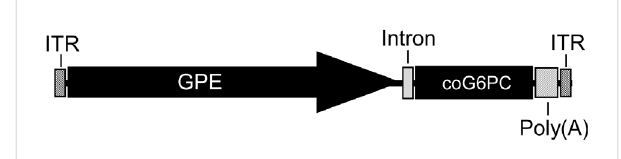
FIGURE 8 The clinical rAAV8-GPE-coG6PC construct. The AAV2/8 serotype contains the construct packaged in the AAV8 capsid. The construct consists of the AAV2 ITR fl anking each end, with the human G6PC promoter/enhancer (GPE, − 2,864 to − 1 nucleotide region of the human G6PC gene), a synthetic intron (137 bp), the codon- optimized (co) human G6PC coding sequence (1074 bp), and a SV40Poly(A)tail(~240 bp).Theoverall sizeis4.8 kb.Speci fi cdetailsof the intron and other sequences are provided in patents US 10113183 B2 and EP 3074510